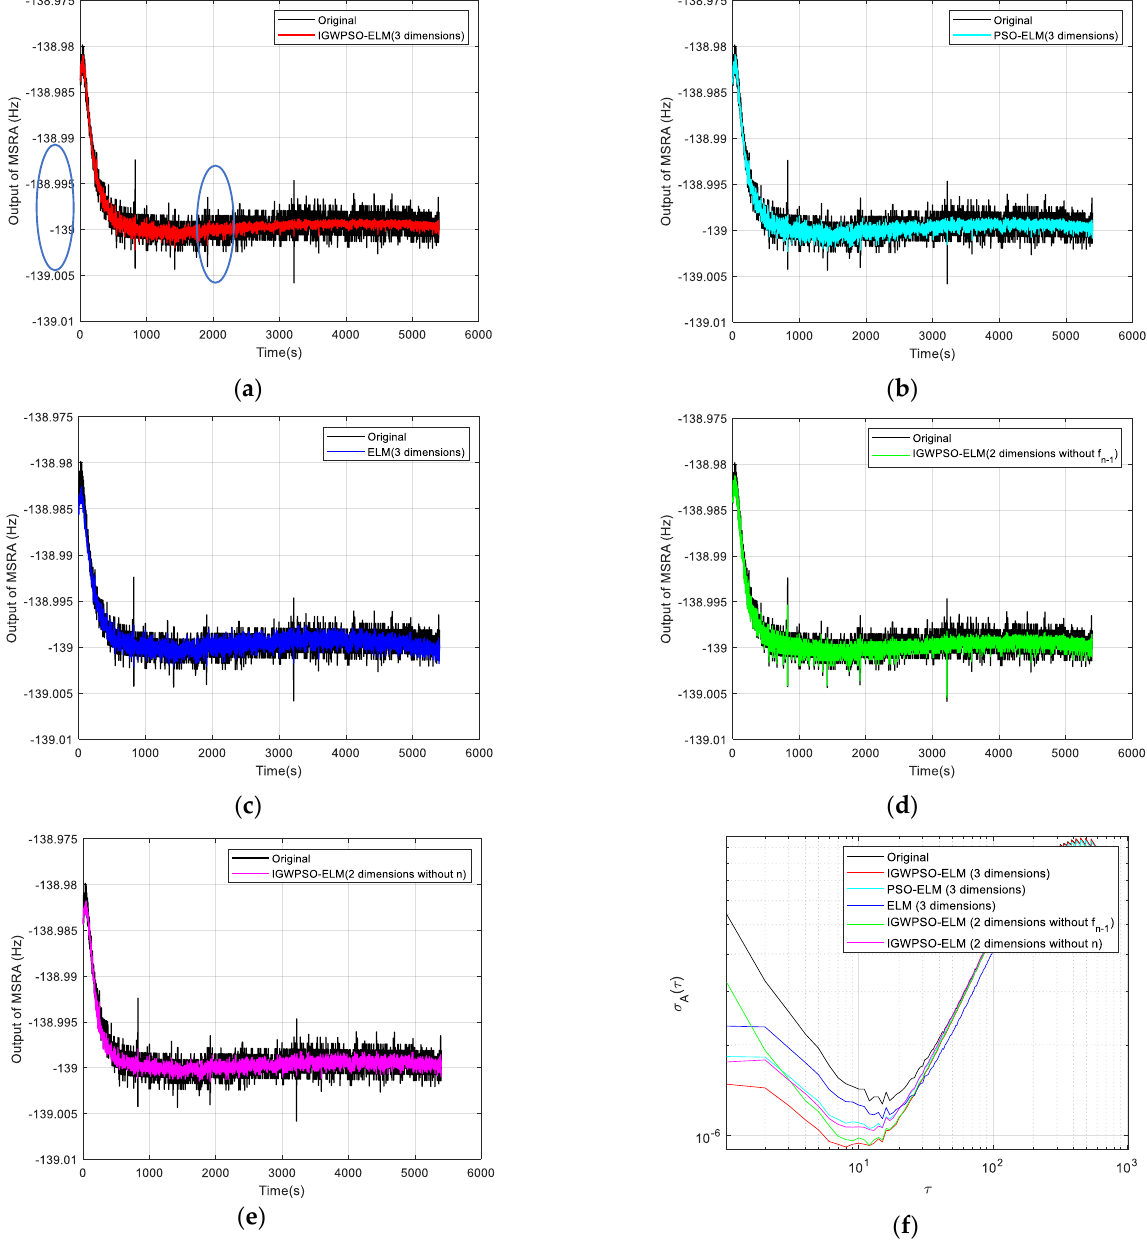
Figure 10. Comparison of test results: ( a ) original output with IGWPSO-ELM (three dimensions) compensated output; ( b ) original output with PSO-ELM (three dimensions) compensated output; ( c ) original output with ELM (three dimensions) compensated output; ( d ) original output with IGWPSO-ELM (two dimensions without f n − 1 ); ( e ) raw output with IGWPSO-ELM (two dimensions without n ) compensation; ( f ) Allan standard deviation curve for six data sets. Table 3. Three random error coefficients of test data after compensated with different types of models.